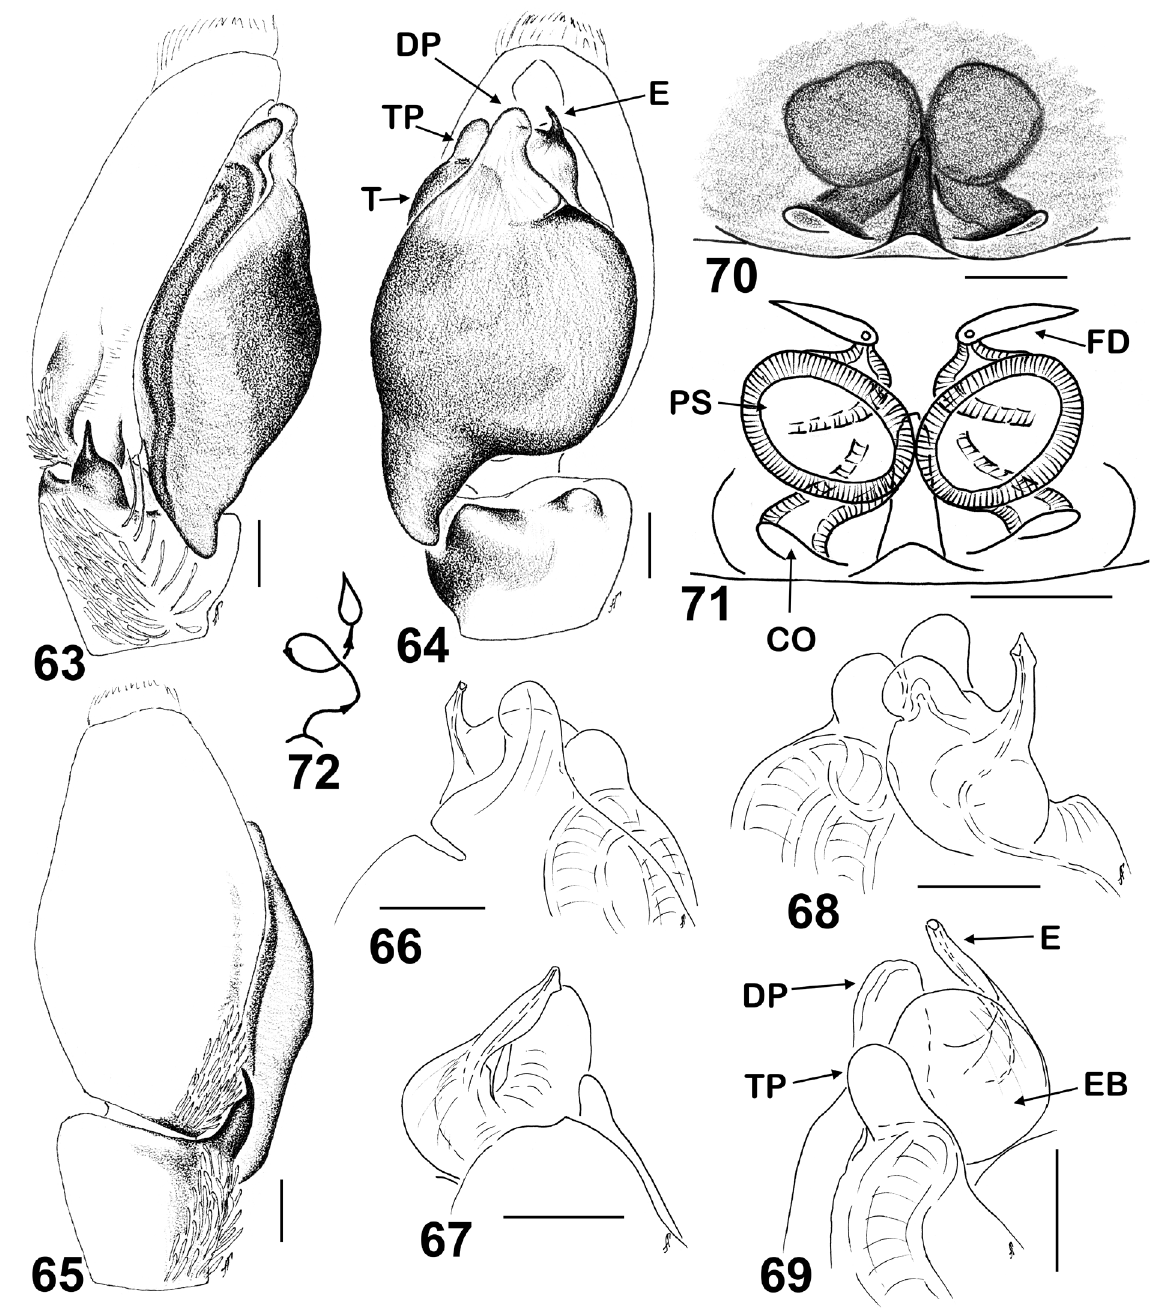
Figs 63–72. Stenaelurillus bandama sp. nov., holotype, ♂ (63–65), paratype, ♂ (66–69) and paratype, ♀ . 63 . Male palp, retrolateral view. 64 . Male palp, ventral view. 65 . Male palp, dorsal view. 66–69 . Embolic division. 66 . Ventral view. 67 . Median view. 68 . Dorsal view. 69 . Retrolateral view. 70 . Epigyne, ventral view. 71 . Spermathecae, dorsal view. 72 . Diagrammatic course of the insemination ducts. Abbreviations: see Material and methods. Scale bars: 0.1